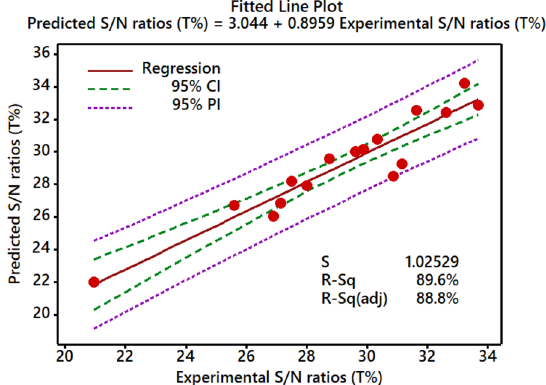
Figure 7. Fitted lines for the experimental S/N ratios (T%) and predicted S/N ratios (T%).